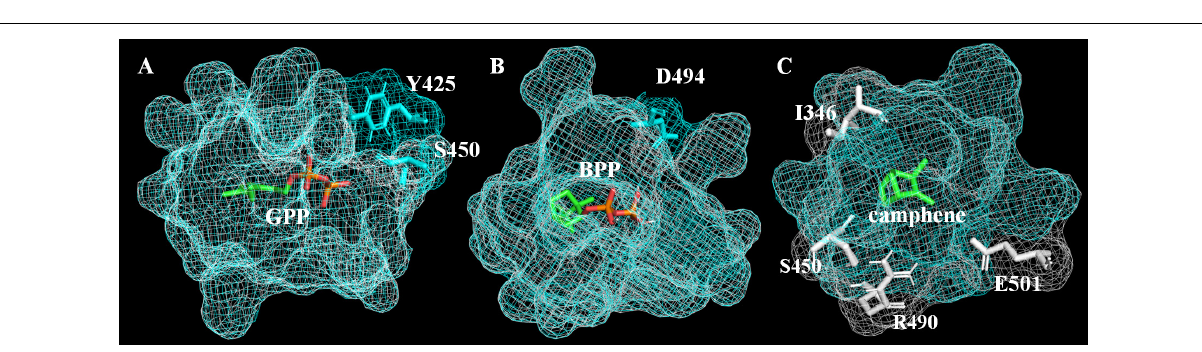
FIGURE 6 | The site-directed mutation of A496G in DTE motif of AlTPS3 changed the major product from camphene to BPP. (A) Alignment of AlTPS3 partial sequence with other BPPSs. The red box represents the DTE conserved motif. The red dot indicates the different amino acid, Ala vs. Gly, between AlTPS3 and other BPPSs. (B) Product percentage of AlTPS3-WT (wild type) and AlTPS3-A496G.